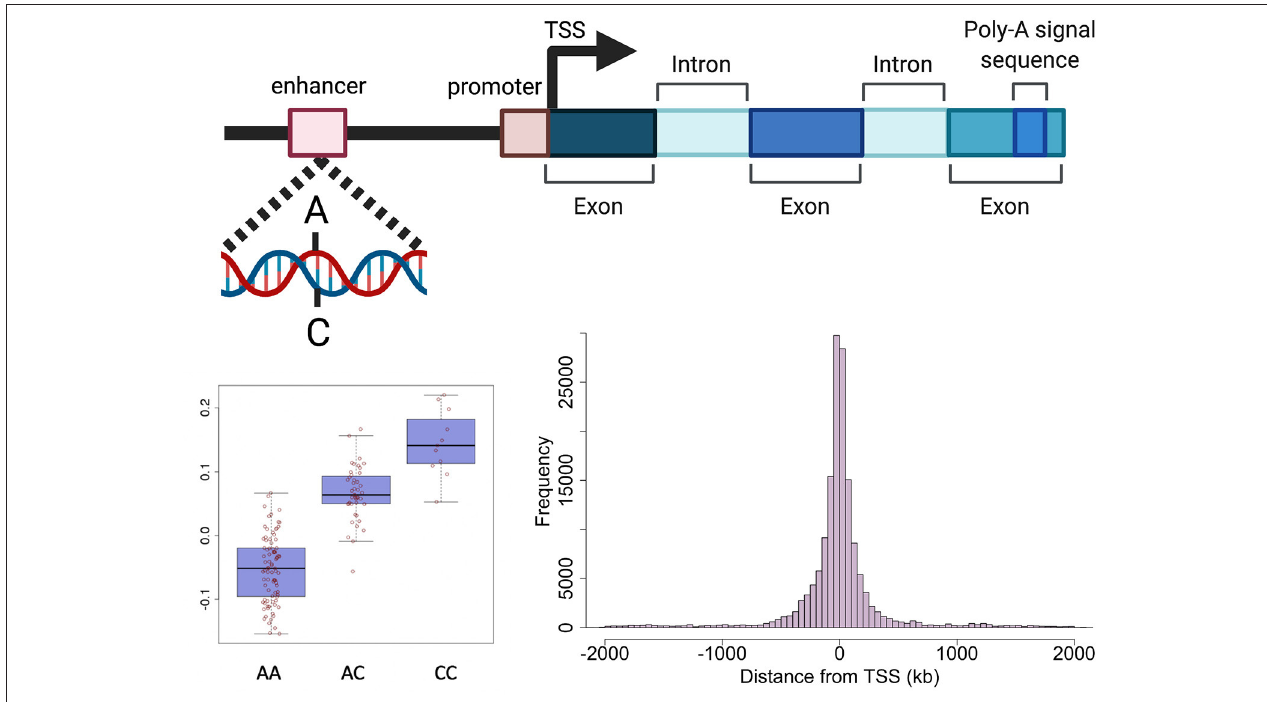
FIGURE 2 | Schematic representation of genetic regulation of gene expression. Expression quantitative trait loci (eQTL) describe the association between genetic variation and variation in the level of gene expression. The top panel depicts how a genetic variant located in a regulatory region (e.g., enhancer) can effect the level of expression of a nearby gene. The presence of a particular allele can be associated with an increase or decrease in expression of the gene as shown in the boxplot in the bottom left panel. The histogram in the bottom right panel shows the distance between variants effecting gene expression and the target gene in human endometrium. Created with